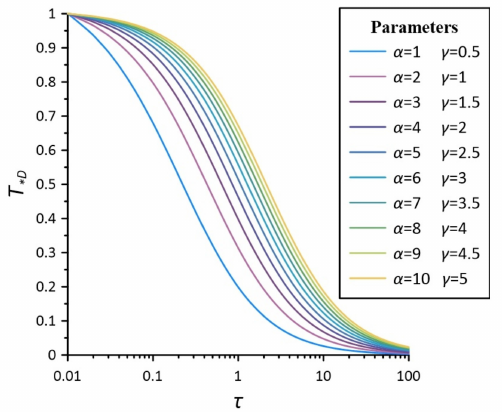
Figure 3. According to the definition of the β parameter, the corresponding flow rate u increases as the β parameter decreases, and the β value has little effect on the curve shape and curvature in this test flow rate. Therefore, the standard curve of intermediate segment β = − 0.5 is chosen for data fitting.